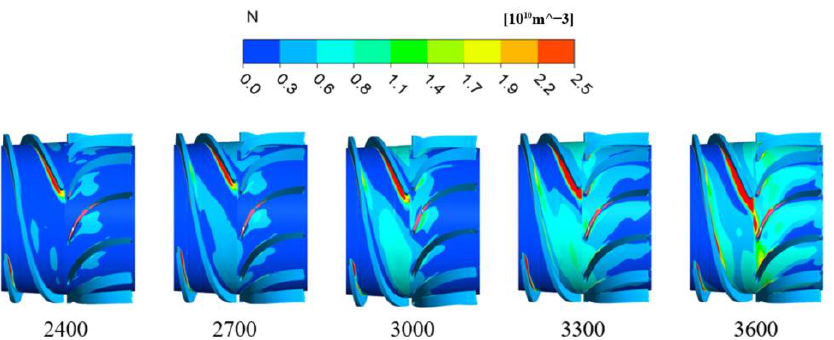
Figure 15. Bubble number density distribution of gas – liquid two-phase media in the pressurization unit of the multiphase pump at different rotational speeds. unit of the multiphase pump at different rotational speeds.